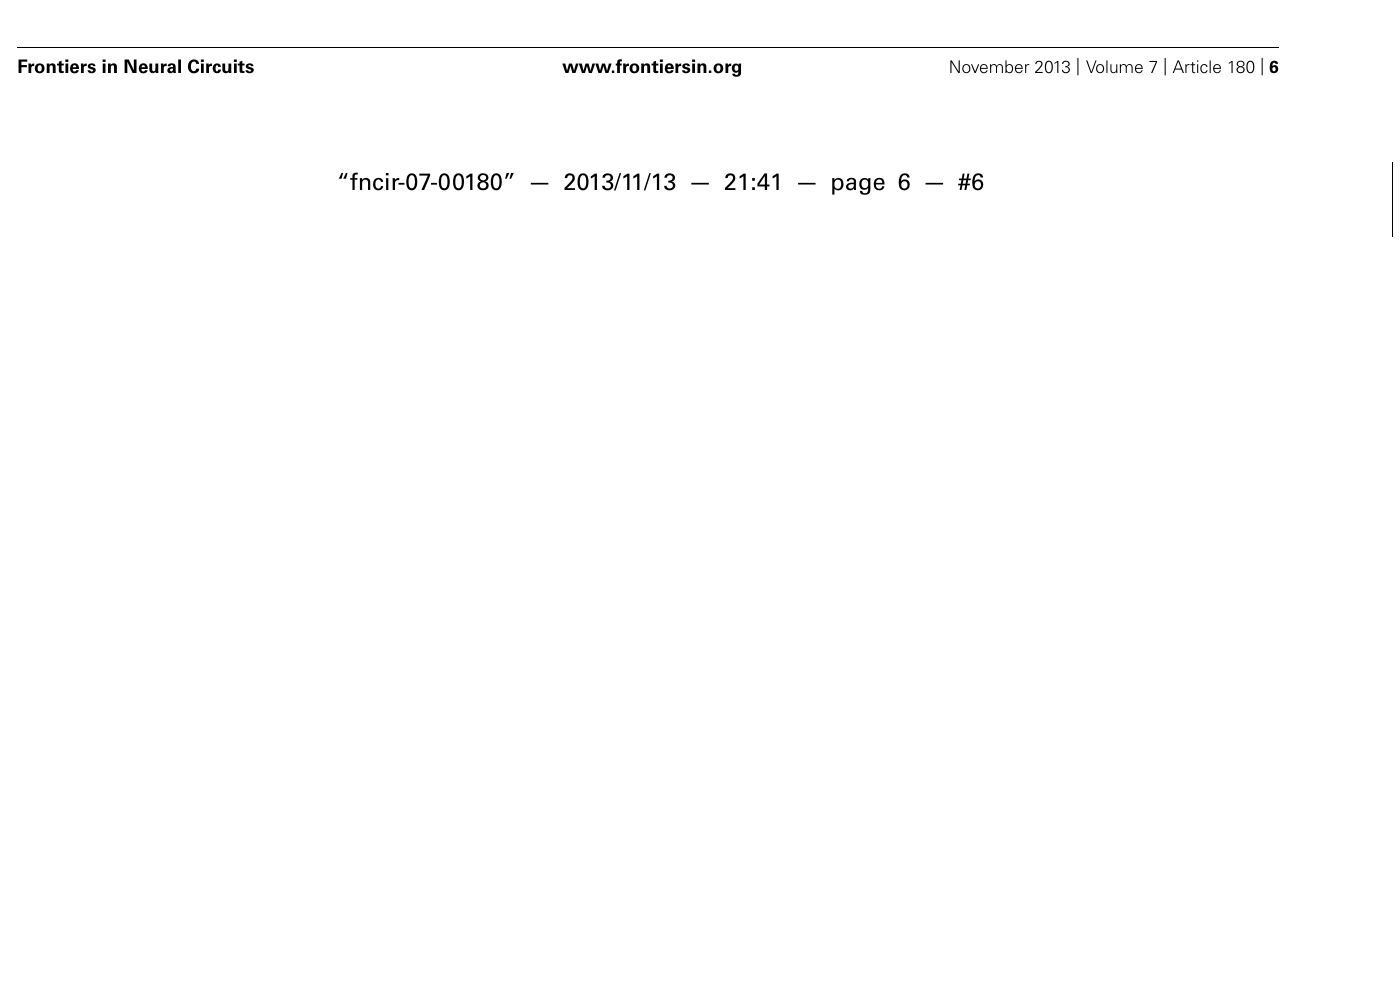
percentage of CR-like activities on Sp2 to indicate the baselin e for learned responses. (C) Averaged EMG amplitude on the last day of training (T7). The EMG amplitudes were normalized to those during the initial 30 ms of CS; n = 10 for each group. No significant differences were observed between the two groups. (D) The effect of different time intervals on trace EBC. The interval between the end of the CS and the beginning of the US was shortened from 500 ms to 250 or 0 ms. The CR% on the last day of training (T7) is shown for each genotype. No significant CR% difference was observed for 500, 250, and 0 ms intervals between wild-type and cbln1 − / − mice ( p > 0.1, two-way repeated measures ANOVA followed by Bonferroni’s correction, n = 8 for each